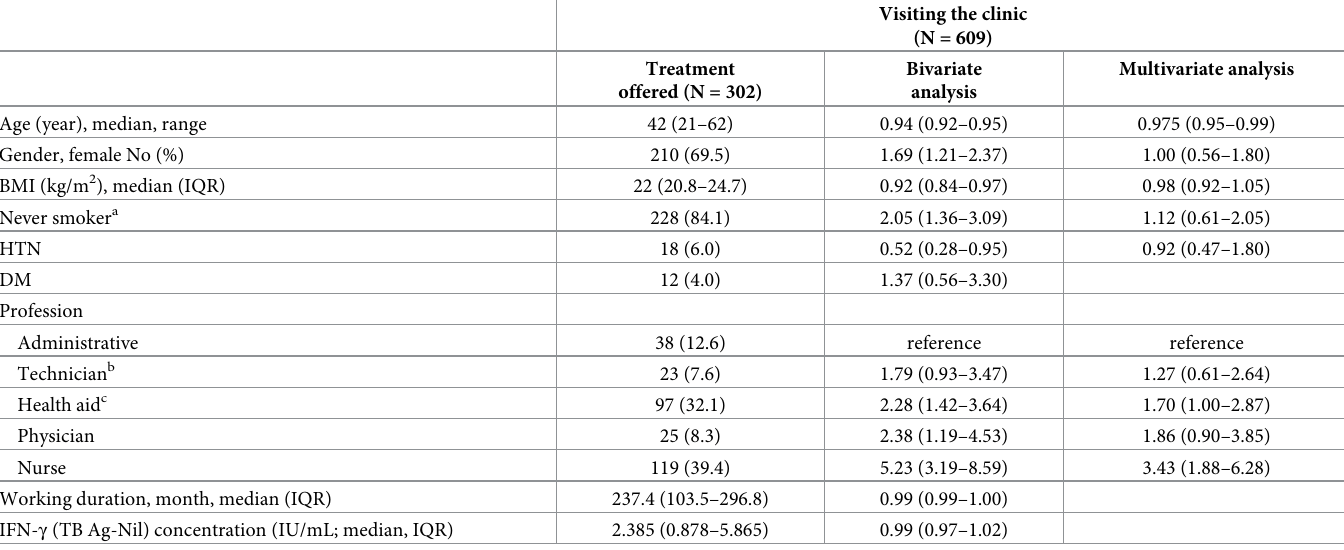
Table 2. Factors affecting the LTBI treatment recommendation by a